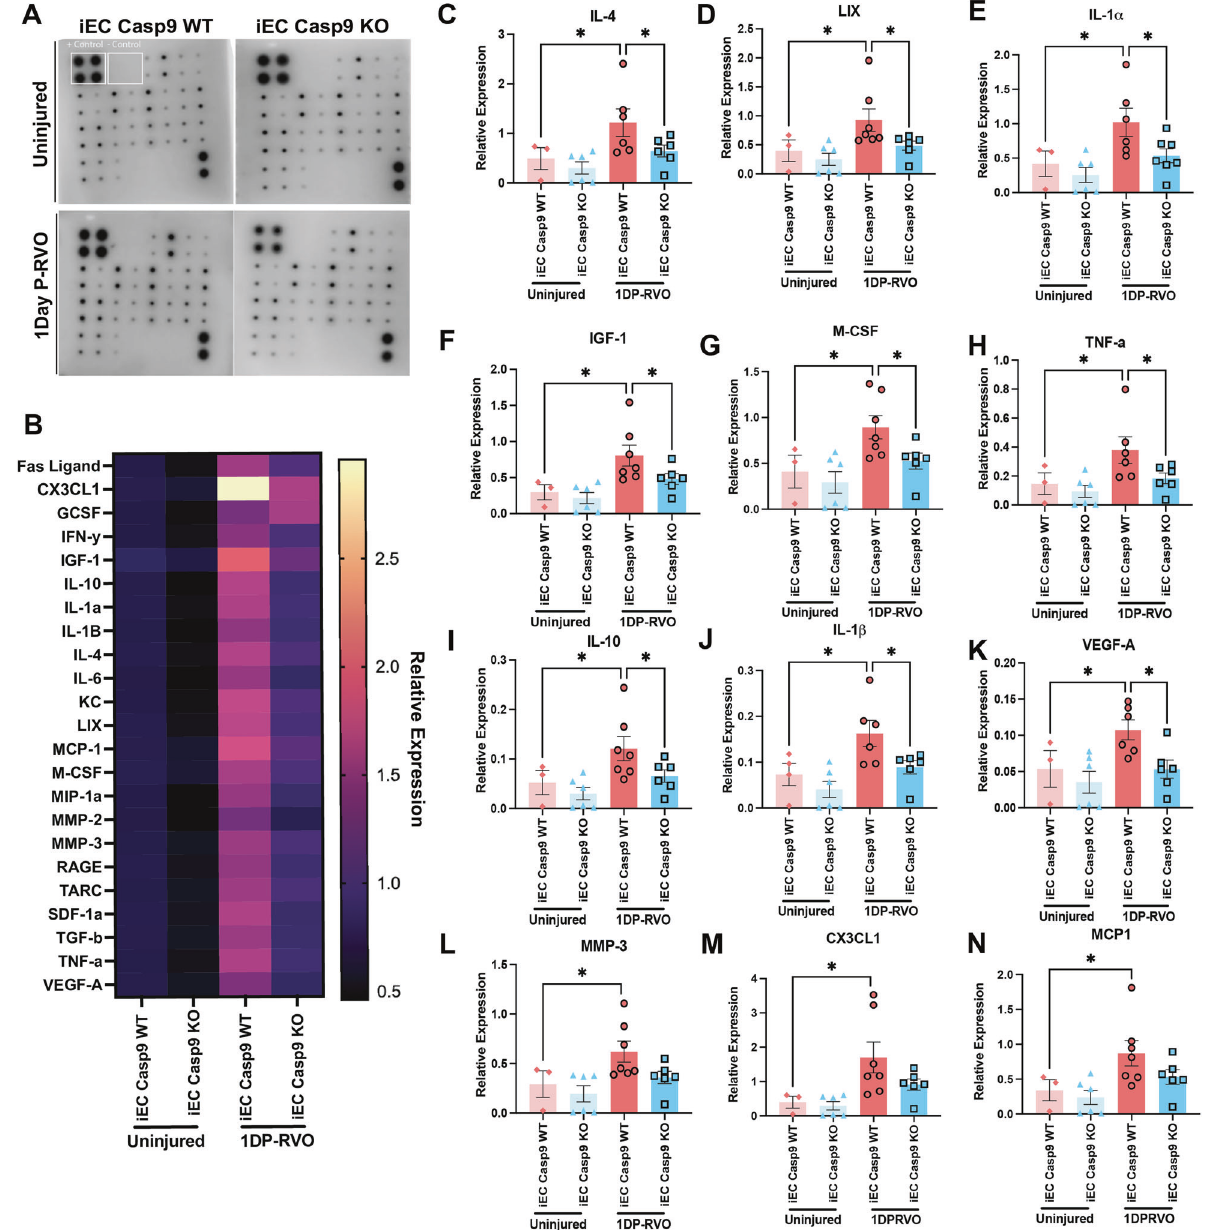
Fig. 2 EC Casp9 regulates an increase in in fl ammatory cytokines one day P-RVO. A Representative images of cytokine arrays of retinas from uninjured iEC Casp9 WT/KO and one day P-RVO iEC Casp9 WT/KO mice. B Heat map array of relative expression of 23 cytokines normalized to positive signal per array blot of iEC Casp9 WT in uninjured iEC Casp9 WT ( n = 3) and KO ( n = 6) and iEC Casp9 WT ( n = 6) and KO ( n = 6) one day P-RVO. C – N Relative expression of induced cytokines one day P-RVO. Error bars mean ± SEM, One-way ANOVA, Fisher ’ s LSD test. * P ≤